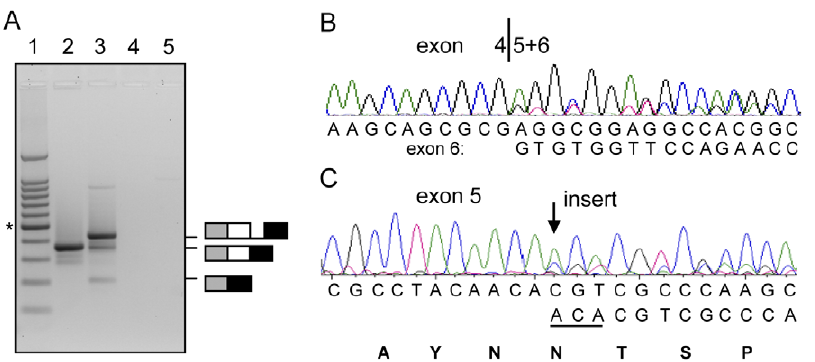
Figure 4. Splicing products of LHX3 RNA in German shepherd dwarfs. (A) Normal splicing of intron 5 as well as retention of the intron was observed in the pituitary of one of the dwarfs (F8). The cDNA fragments were generated with Platinum pfx polymerase and primers LHX3 ex4-7 F and LHX3 intron5 R in exons 4 and 6, respectively (Table S4). The fragments were analyzed by agarose gel electrophoresis. Lane 1: 100 bp size standard, * indicates the 500 bp fragment; lane 2: fragment derived from a control dog of mixed breed without the 7 bp deletion in intron 5 or other LHX3 mutations; lane 3: fragments derived from a dwarf homozygous for the deletion in intron 5; lanes 4 and 5: as lanes 2 and 3, respectively, without reverse transcriptase. The structure of the fragments as indicated by the drawings was confirmed by DNA sequence analysis of the excised bands. Open box: exon 5, closed box: exon 6, line: intron 5. (B) The cDNA sequence of the same dwarf, obtained with primers in exons 4 and 7 and standard taq DNA polymerase, indicates that exon 5 was skipped in a proportion of the transcripts. (C) The other dwarf (F9) for which pituitary RNA was available displayed heterozygosity for an insertion of an ACA trinucleotide sequence (underlined) in exon 5. This insertion translates into insertion of an asparagine residue (underlined) in the amino acid sequence (bold).